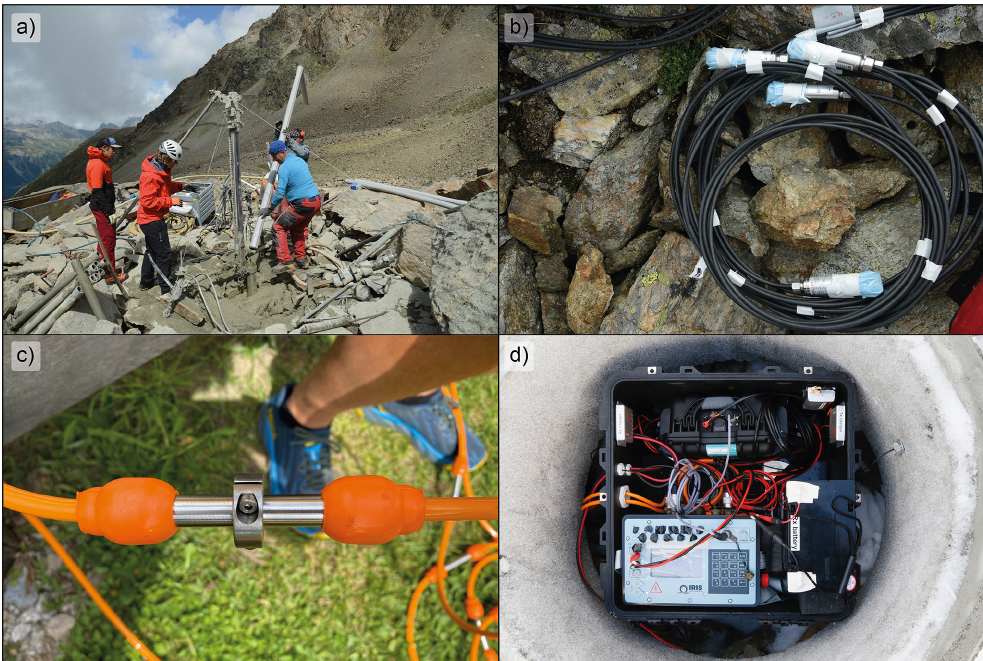
Figure 2. (a) Drill and protective PVC pipe used to drill boreholes B3, B4 and B5 on Schafberg rock glacier in August 2020. (b) Piezometers and temperature sensors ready to be installed in B5. (c) Stainless steel ring mounted on cross-borehole ERT electrode to improve ground contact. (d) Cross-borehole ERT logging system for B3 and B4 in a concrete chamber (ERT instruments in Fig.